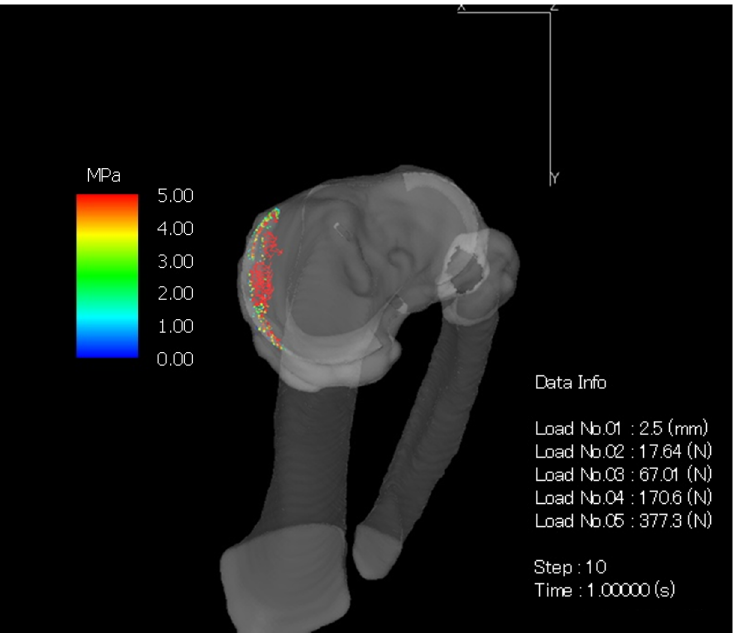
Figure 3. Compression stress using computed tomography-based finite element method (CT-FEM) representing the shape of the meniscus.